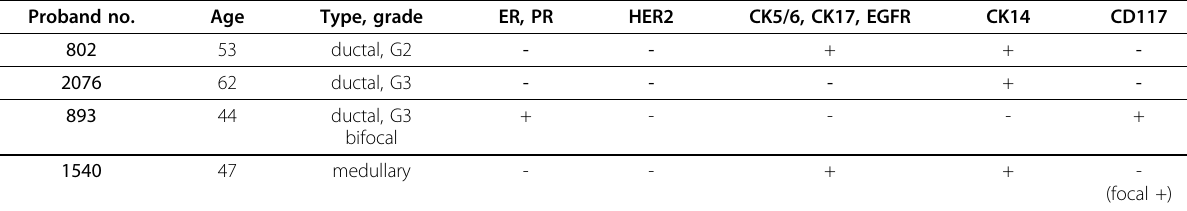
Table 3 Characteristics of breast cancers with c.509_510delGA deletion in the PALB2 gene Proband no.